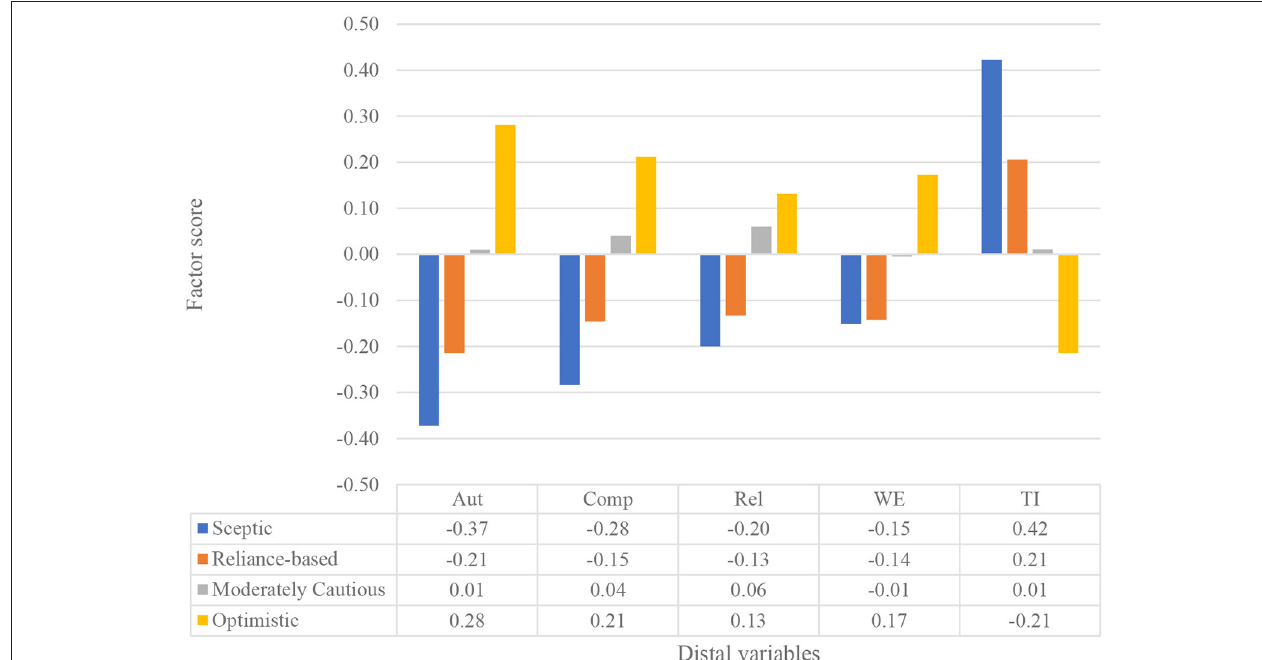
FIGURE 2 | Mean scores of four latent profiles.